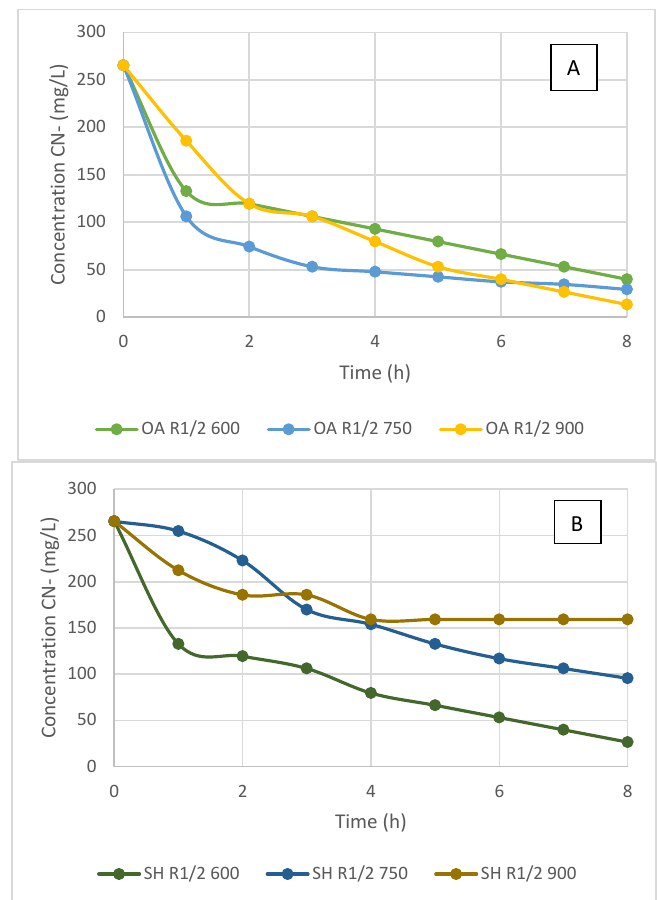
Fig. 6: Influence of the calcination temperature of prepared ferrites on the oxidation of cyanide ion (15 g/L, 180 NL/h, 5.5-8.5 mg O 2 /L, 800 rpm). (a) Hydro-chemical pathway with oxalic acid (OA). (b) Co-precipitation